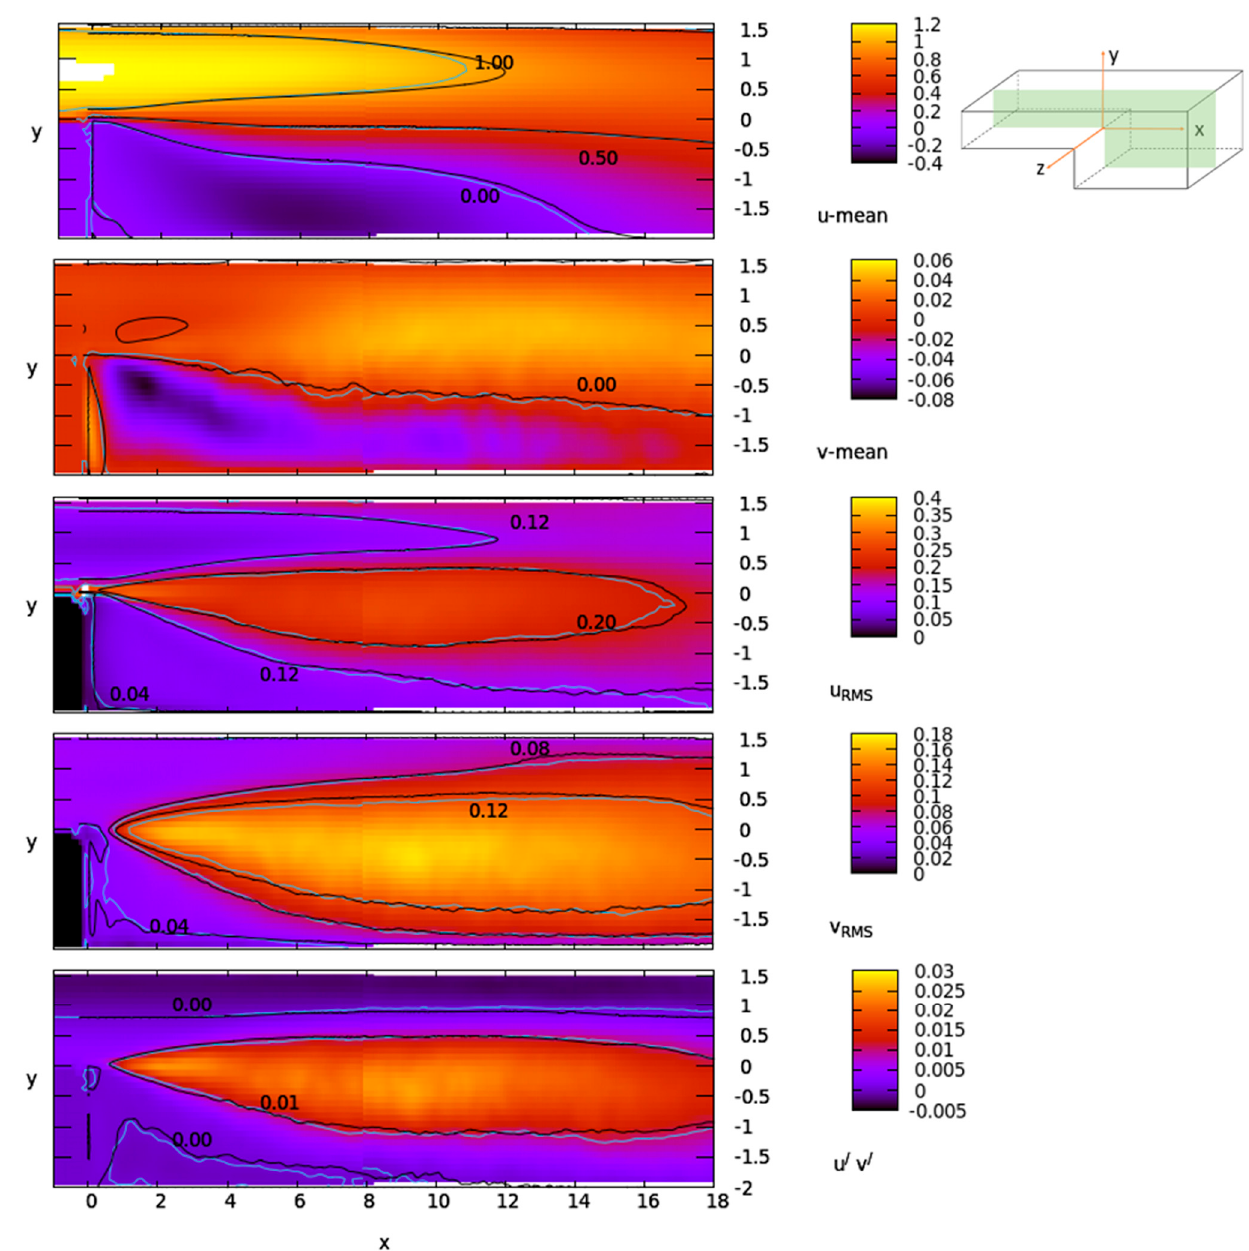
Figure 5. Time-averaged velocity field of case ‘z − 0’: components u and v ( top pair ), u RMS ,v RMS , u’v’ ( bottom triplet ) in plane z = 0. PIV experiment: color-scale and blue contours. DNS—black contours.